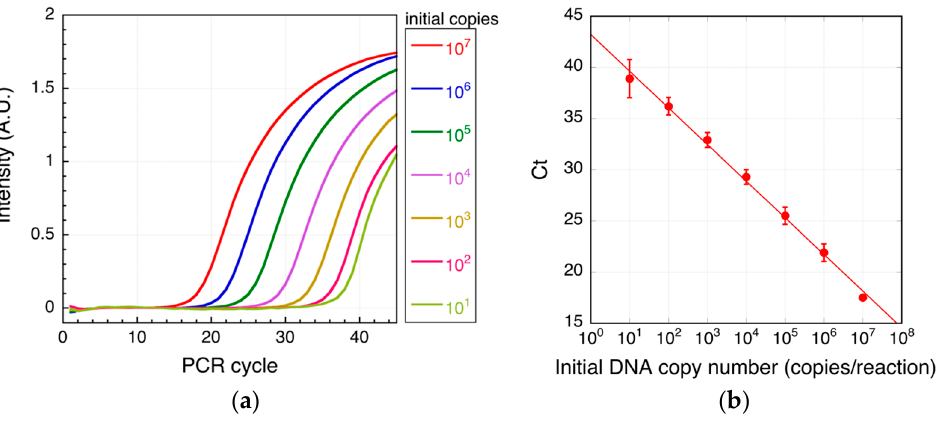
Figure 3. Real-time PCR of target DNA. Shown are typical real-time PCR intensity curves ( a ) and threshold cycles ( C t; b) for each of the indicated target DNA initial copy numbers. In ( b ), mean values are shown; the error bars are the standard deviation from three independent experiments. The solid line is the fitted line ( R 2 = 0.996). R 2 is the coefficient of determination.